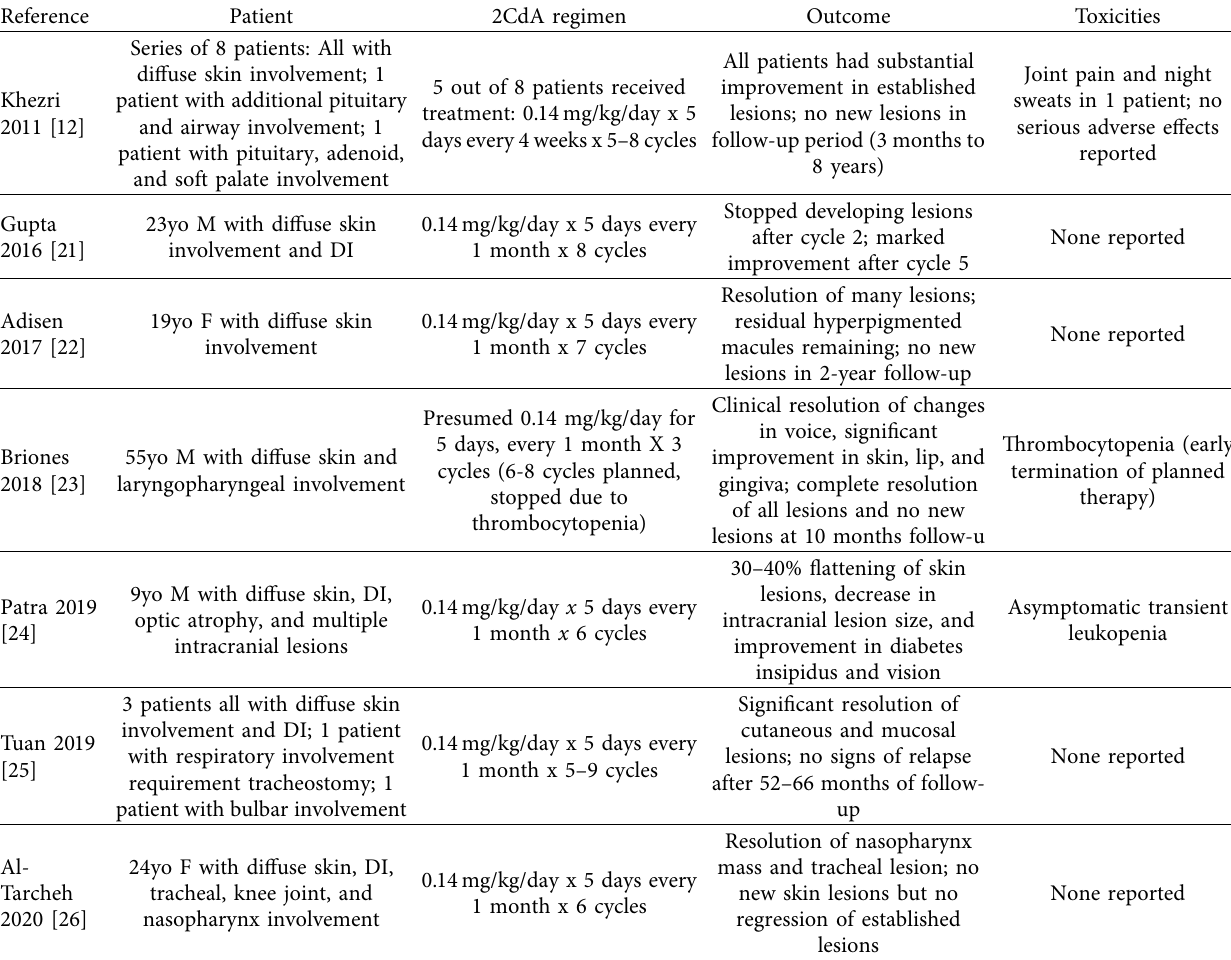
Table 1: Summary of published responses to 2CdA in xanthoma